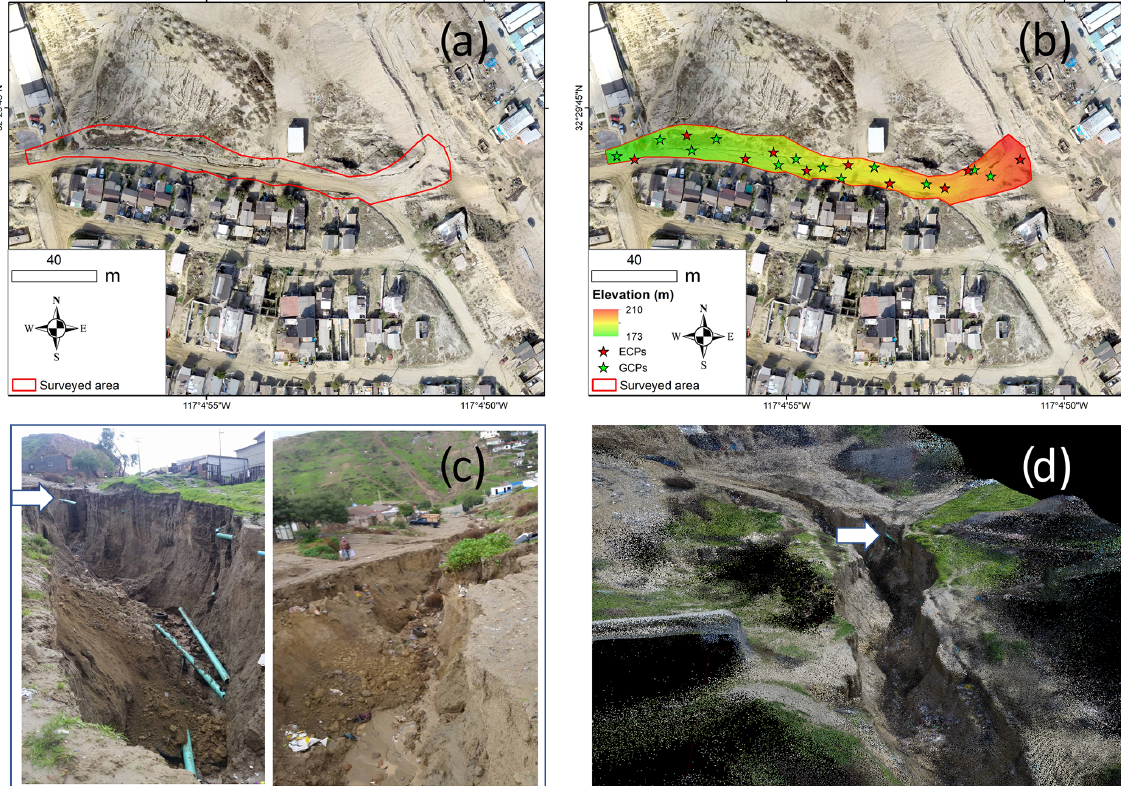
Figure 5. Mega-gully B formed on 16 December 2016 triggered by WRIF: (a) orthophoto acquired before the WRIF showing the extent of the surveyed area centered on the red polygon, (b) the resulting DSM after the WRIF, (c) images depicting the mega-gully with view angles looking upslope and downslope of the WRIF, and (d) a screenshot of the resulting point cloud. Table 2. Sediment generation by process during storm events with WRIFs in the Los Laureles Canyon